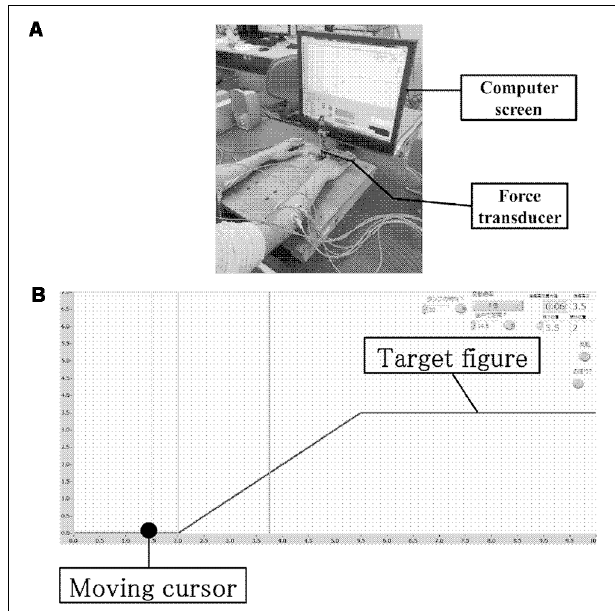
FIGURE 2 | Experimental environment and computer screen. (A) Experimental environment. (B) Computer screen showing the tracking monitor and tracking